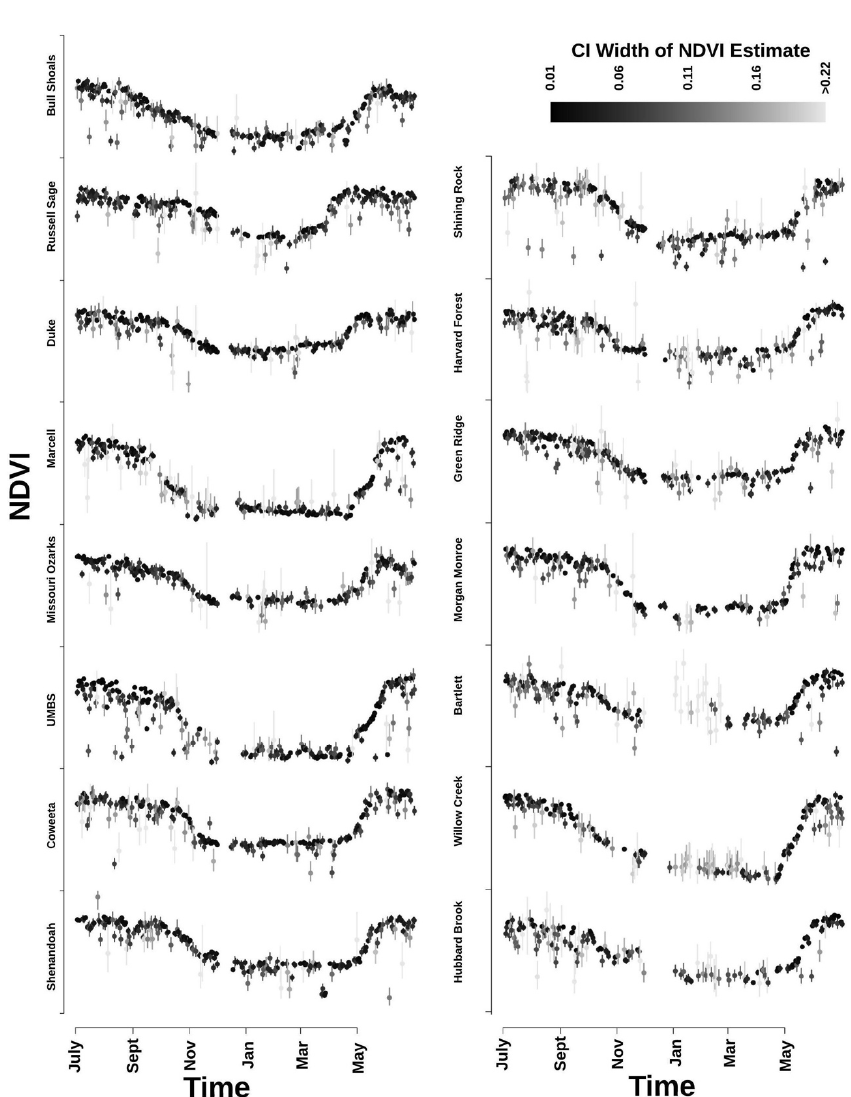
Figure 3. Time-series for the fifteen deciduous sites (labeled on the y-axis besides each time-series) for the midday maximum NDVI values fitted from the diurnal fit method. The tick marks on the y-axis indicate 0.0 NDVI for the site labeled above the tick and 1.0 NDVI for the site labeled below the tick. The shading of the points is scaled to be proportional to the width of the 95% credible interval (CI) of each NDVI estimate (i.e., estimates with smaller uncertainties are darker). The CI’s are provided as vertical lines with the same shading. Sites are ordered (top-to-bottom, left panel to right panel) by the total number of days with >10 observations (Bull Shoals had the most and Hubbard Brook had the least). The majority of the diurnal fit estimates with a tight CI fall along the expected seasonal pattern for NDVI and estimates that do not usually have a high uncertainty.